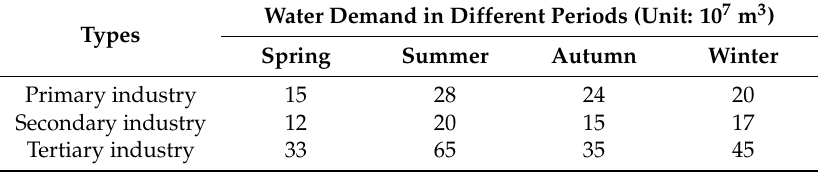
Table 7. The forecasting of water demand in Beijing city by sector